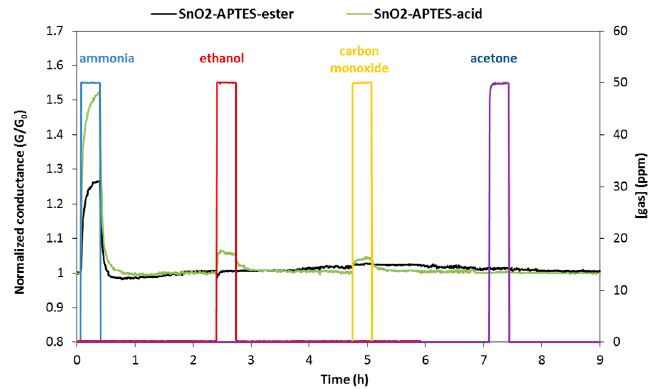
Figure 3. The sensor response of SnO 2 -APTES-ester and SnO 2 -APTES-acid upon exposure to 50 ppm of ammonia, ethanol, carbon monoxide and acetone gases in humid air (5%RH) at 25